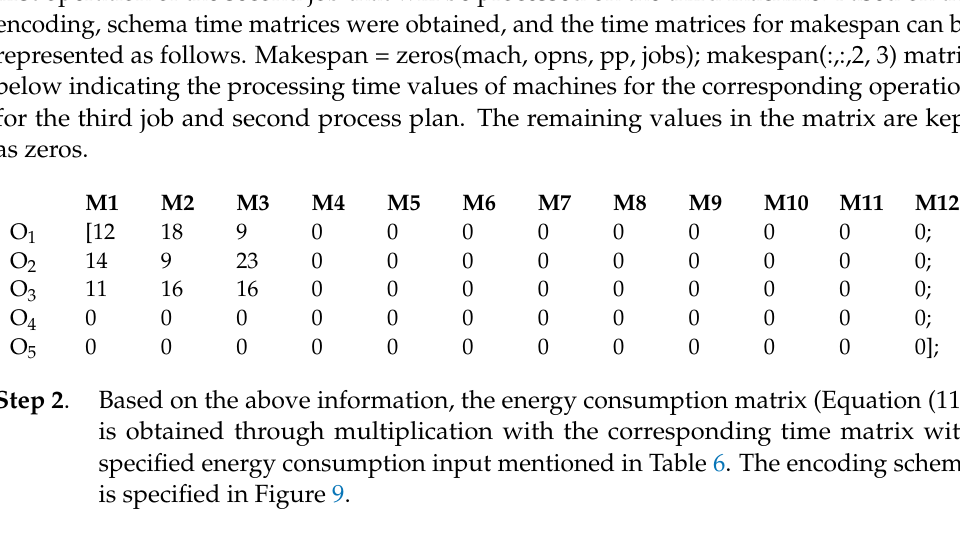
Table 6. Energy and reliability